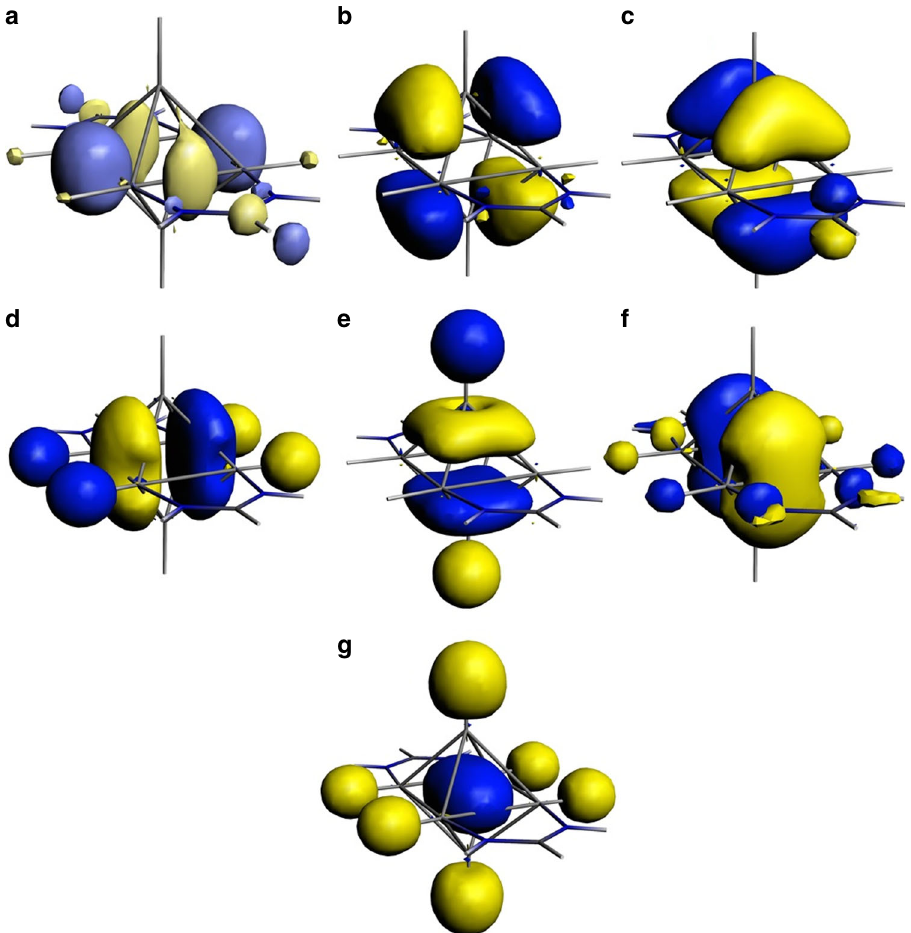
Fig. 3 Representations of the aluminium-based MOs of [Al 6 H 6 ( H Fiso) 2 ] 2 − . a LUMO + 7 (5.64 eV), b HOMO (3.42 eV), c HOMO-1 (3.30 eV), d